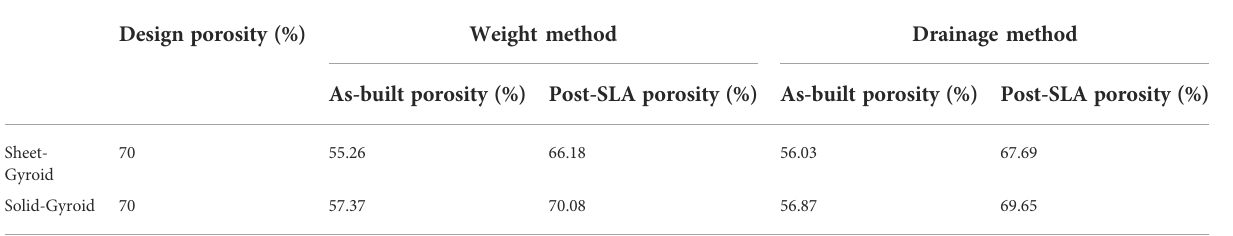
TABLE 4 Pore characterization of the porous